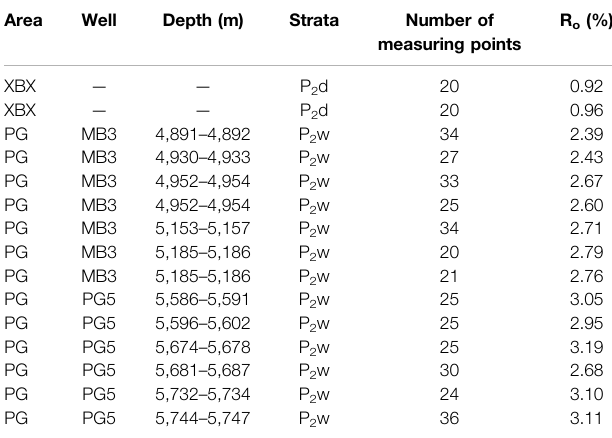
TABLE 2 | The vitrinite re fl ectance (R o ) of the shale samplesfrom the XBX outcrop and PG gas fi eld in the Sichuan Basin. Area Well Depth (m) Strata Number of